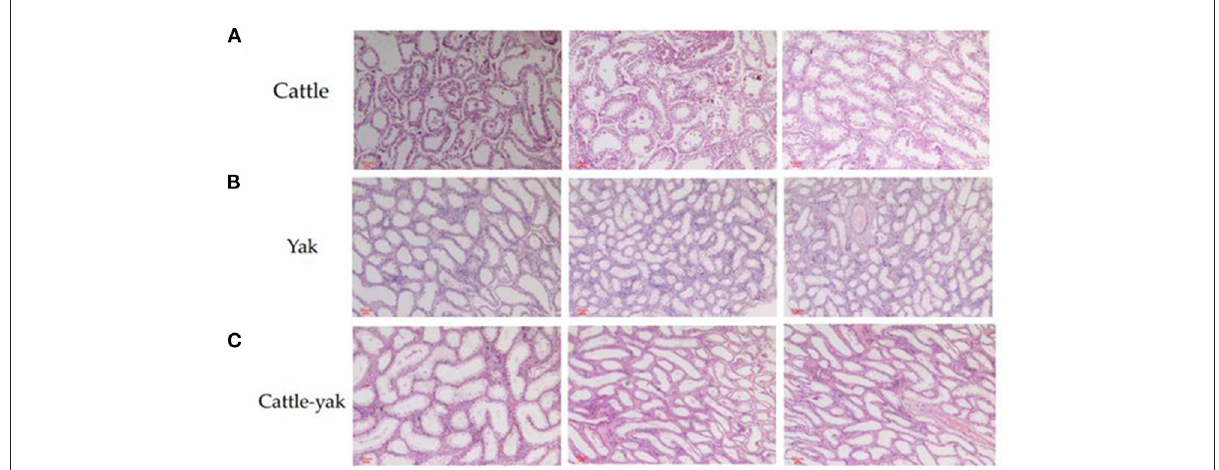
FIGURE1 The histological differences among the testis of cattle, yak, and cattle-yak. The cattle longitudinal section of testicular tissues (A) and yak longitudinal section of testicular tissues (B) showed that the relatively thick seminiferous tubules filled with spermatogonia, spermatocytes, and spermatids. On the contrary, seminiferous tubules of cattle-yak (C) were highly vacuolated and there are few spermatids can be seen.